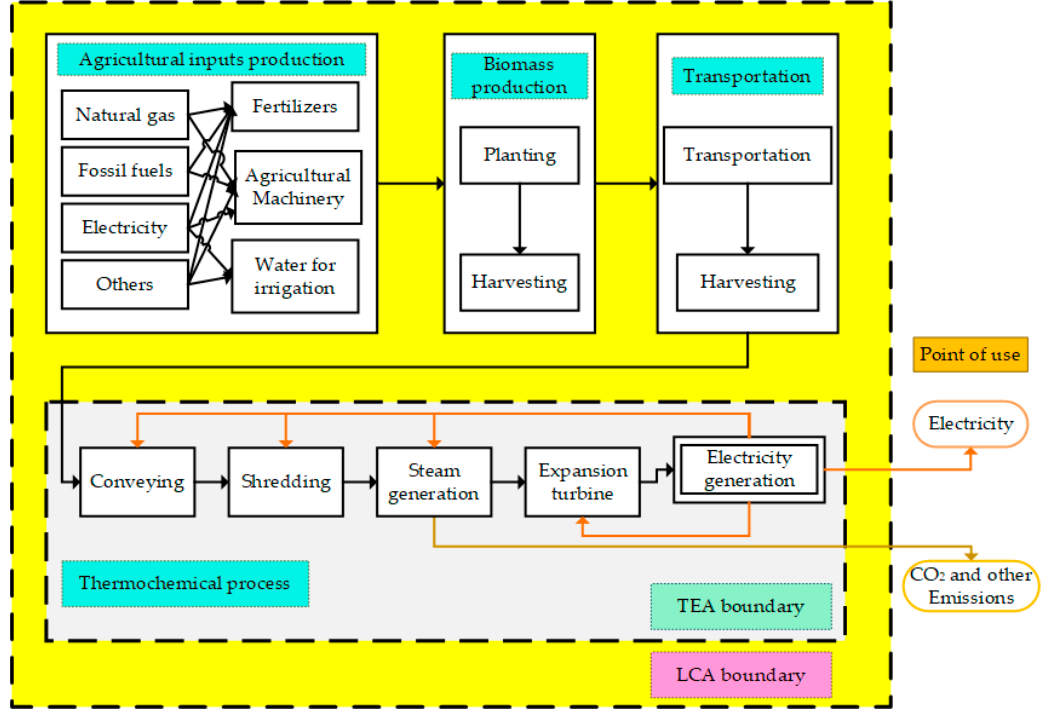
Figure 2. System boundary showing the techno-economic (TEA) and life-cycle assessment (LCA) boundary for the lignocellulosic power production. Grey color represents the TEA boundary, while the yellow color represents the LCA boundary.